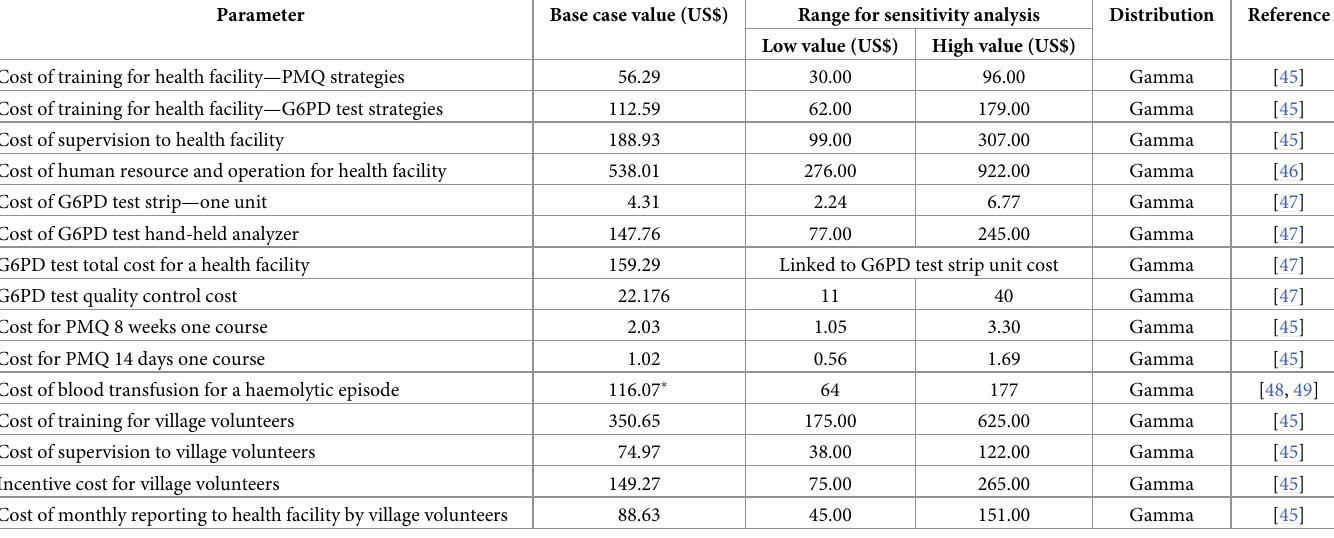
Table 3. Cost input parameters, cost for one year of implementation at one health